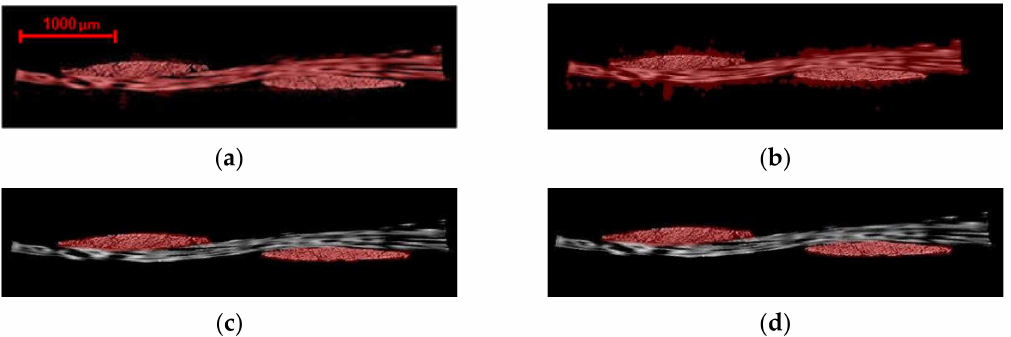
Figure 13. Segmentation steps: ( a ) thresholding; ( b ) growing; ( c ) trimming by brush tool; ( d ) after smoothing and